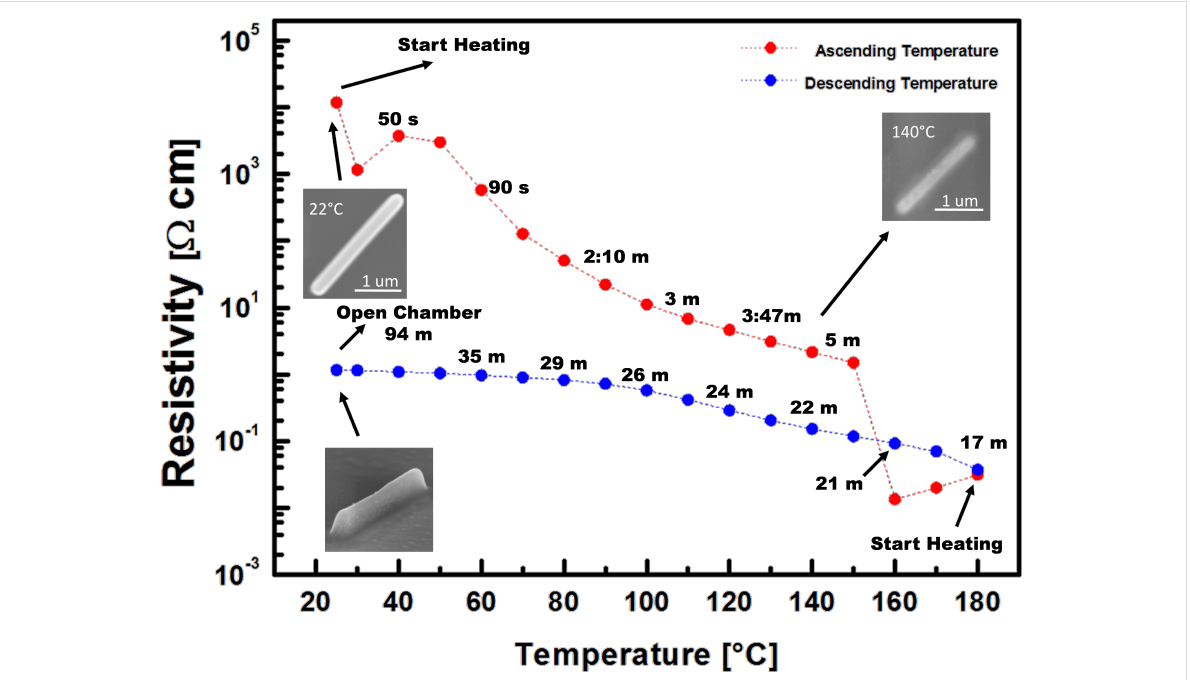
Figure 1: Figure 8 in the original article: Calculated resistivity from the resistance measurement of a Cu–C line during in situ post-growth heating with a hot plate (red dots) and cooling down (blue dots) inside the SEM chamber. The resistance did not change when opening the chamber. The top SEM images show the morphology changes of an adjacent FEBID line which was observed simultaneously during the in situ resistance measure-